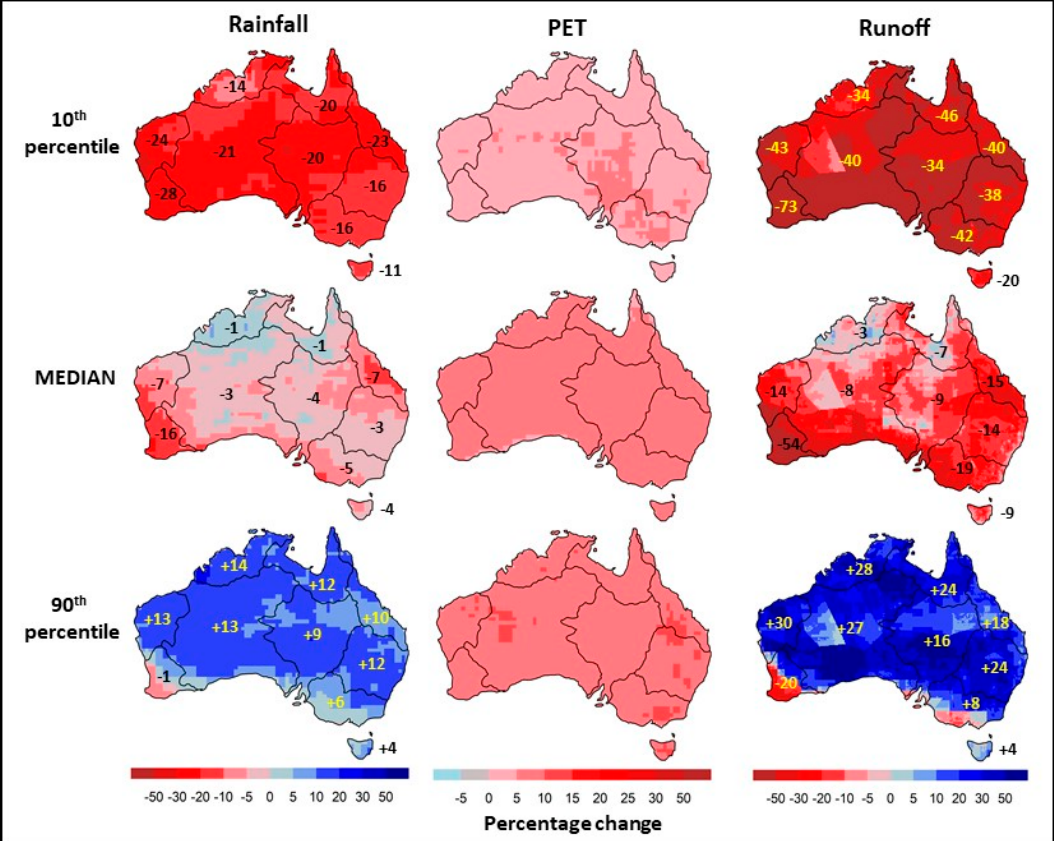
Figure 7. Projected percentage change in mean annual rainfall, potential evapotranspiration (PET) and runoff (median and the 10th and 90th percentile values from hydrological modelling informed by projections from the 42 CMIP5 global climate models) for dRCP8.5 for 2046–2075 relative to 1976–2005 (adapted from [14]).